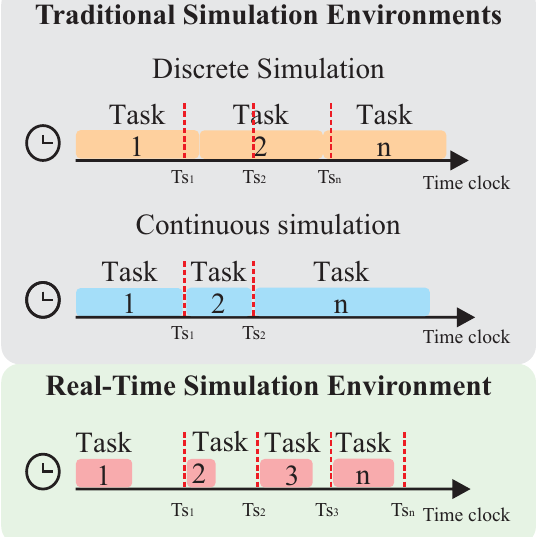
Figure 2. Types of simulation